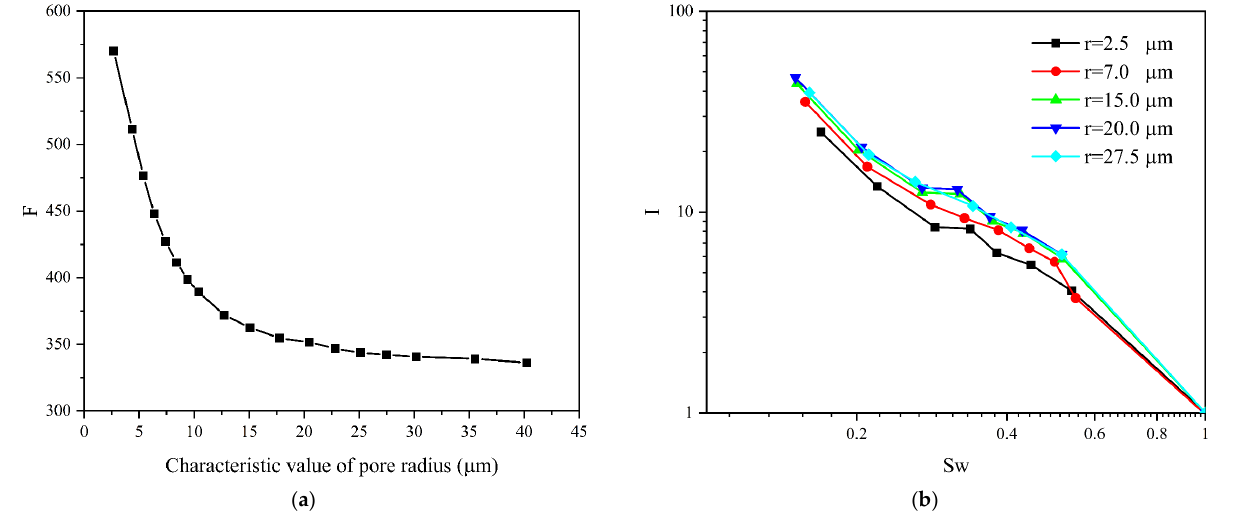
Figure 16. Effect of the characteristic value of pore radius on rock electrical properties: ( a ) relationship curve between characteristic values of different pore radii and formation factors; ( b ) I-Sw curve under characteristic values of different pore radii.